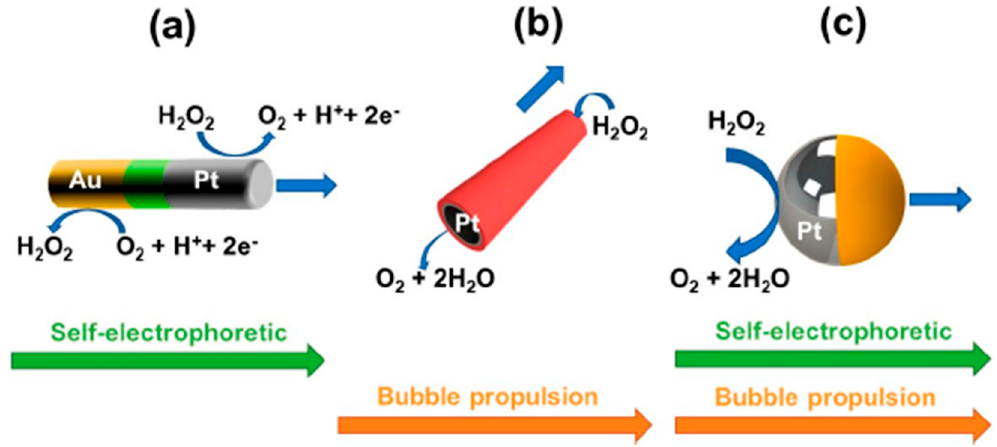
Figure 10. Magnetic Janus motors for biosensing applications and related propulsion mechanisms: Nanowires ( a ), tubular micromotors ( b ) and spherical particles ( c ). Reprinted from Reference [15] with permission.